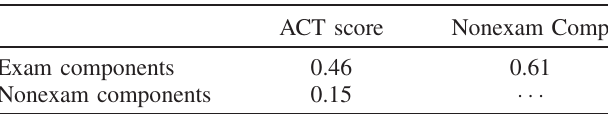
TABLE IX. Correlations for the calculus-based course. The results are very similar for the non-calculus-based